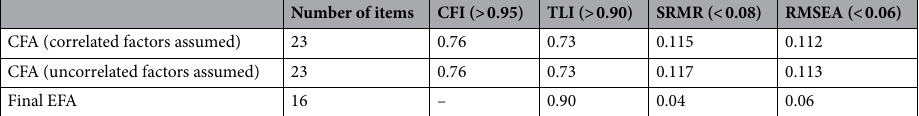
Table 2. Fit indices for factor analysis models. CFA confirmatory factor analysis, EFA exploratory factor analysis, CFI Comparative Fit Index, TLI Tucker-Lewis Index, SRMR Standardized Root Mean Residual, RMSEA Root Mean Square Error of